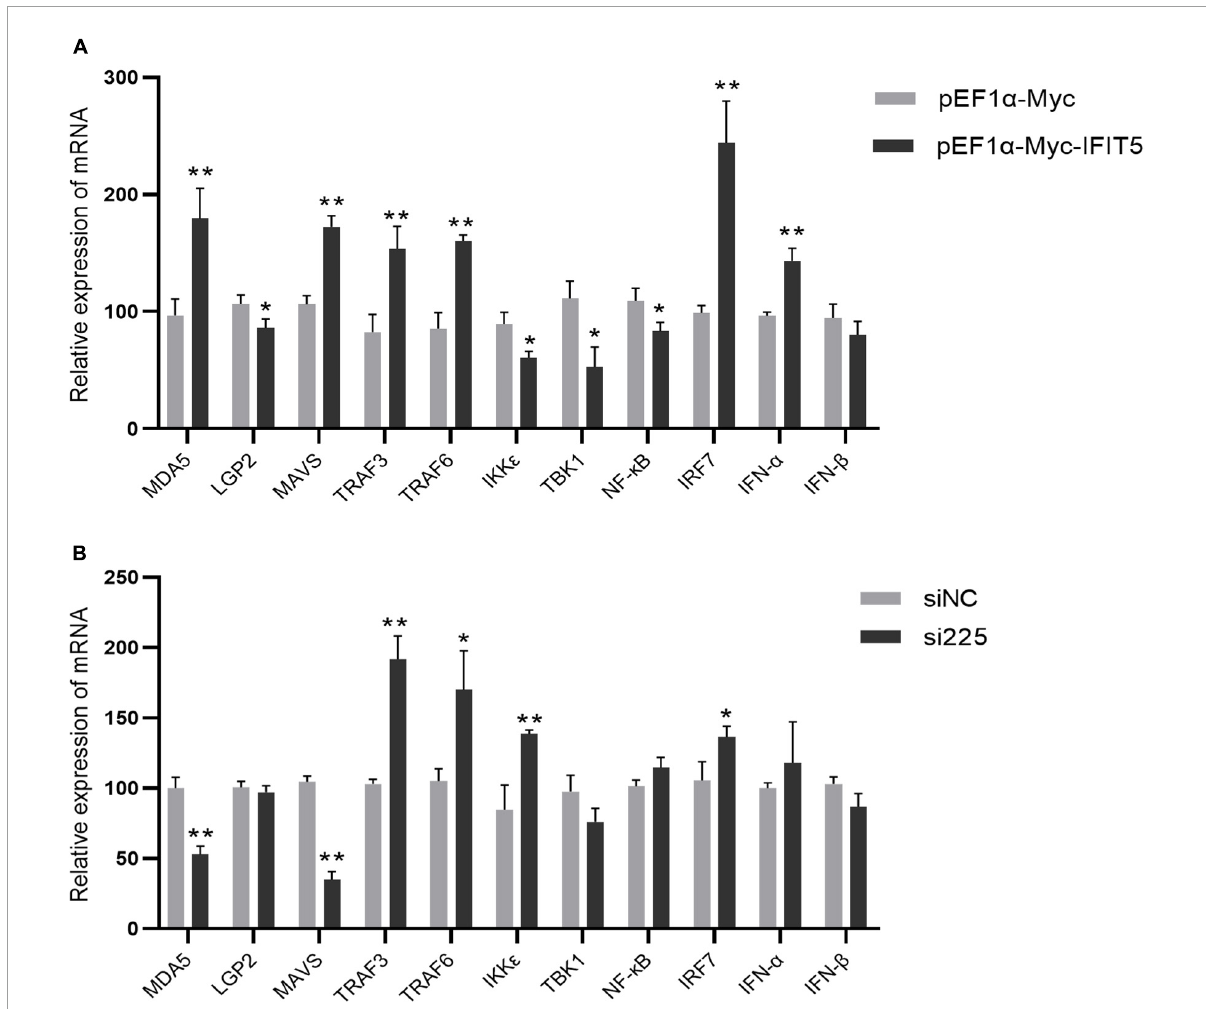
FIGURE9 IFIT5 acts as a positive feedback regulator in natural immune signaling pathways. DF-1 cells were transfected with pEF1 α -Myc-IFIT5 or pEF1 α -Myc plasmids and infected with the ARV strain S1133 (MOI = 1). Expression changes in genes related to the innate immune signaling pathway were measured by real-time quantitative PCR (A) at 24 h after infection. DF-1 cells were transfected with si225 or siNC and infected with ARV strain S1133 (MOI = 1). Expression changes in genes related to the innate immune signaling pathway were measured by real-time quantitative PCR (B) at 24 h after infection. The data are the mean ± SD of three independent experiments. Asterisks indicate significant differences (* P < 0.05, ** P <